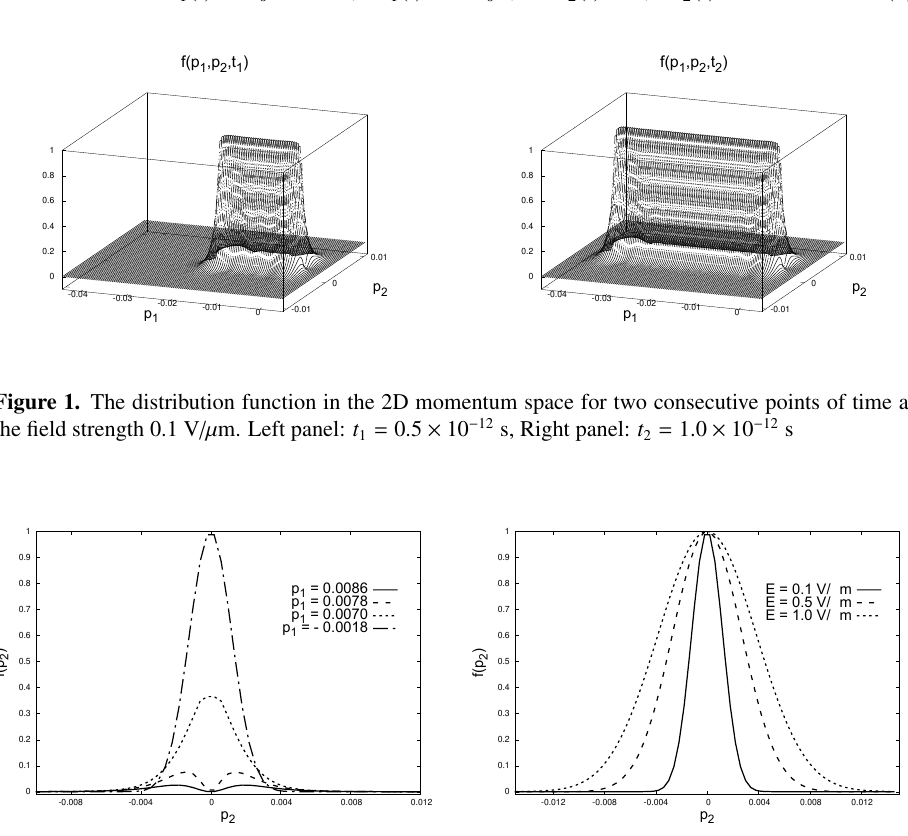
Figure 2. Left panel: The cross section f ( p 1 , p 2 ) of the distribution function for small | p 1 | values, Right panel: The “constant” shape of the cross section f ( p 1 , p 2 ) for E = 0 . 1 , 0 . 5 and 1 . 0 V / µ